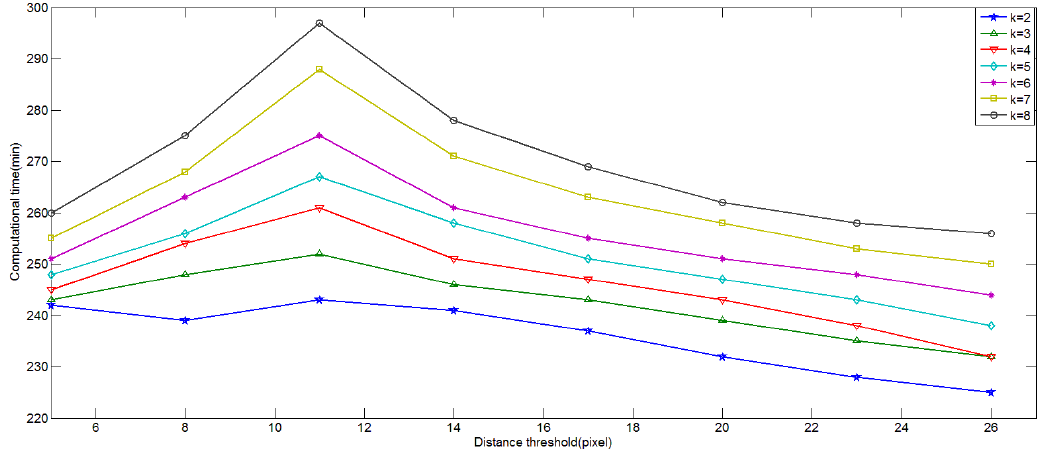
Figure 18. Computational time for generating BOW features with different distance thresholds and number of clusters over WHU-RS dataset.